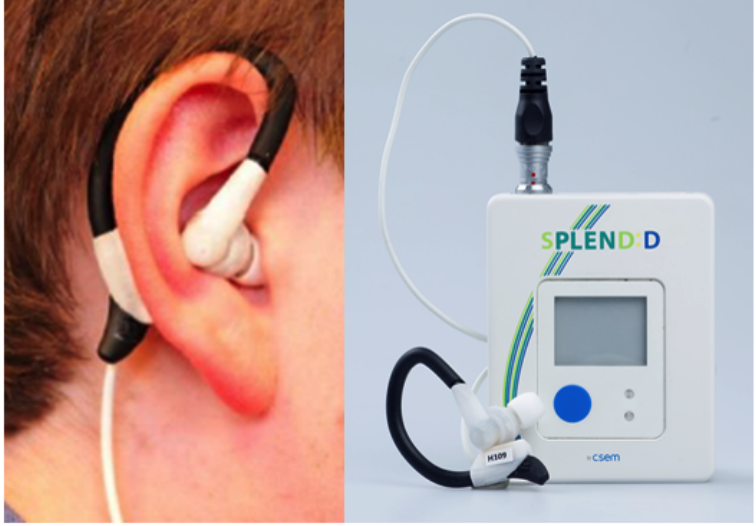
Figure 4. First wearable version of the eating detection sensor (left: the eating detection sensor; right: the eating detection sensor and the datalogger).